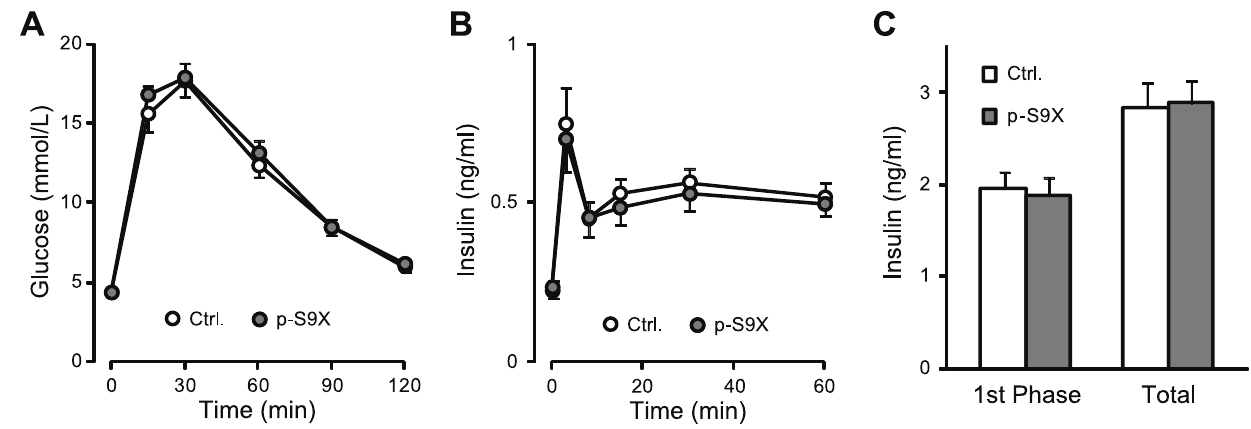
Figure 2. Normal glucose tolerance and invivo insulin secretion in p-S9X mice. ( A ) Intraperitoneal glucose tolerance test (IPGTT) in p-S9X and control mice. p-S9X mice (filled circles, N=16) showed the same glucose increase and clearance as control mice (open circles, N=15). ( B ) Insulin secretion in vivo induced by i.p. injection of glucose in p-S9X and control mice. Plasma insulin levels were determined in control (open circle, N=21) and p-S9X mice (filled circle, N=21) after i.p. injection of glucose. ( C ) Area under curve for the insulin secretion curves in (B). Data are presented as